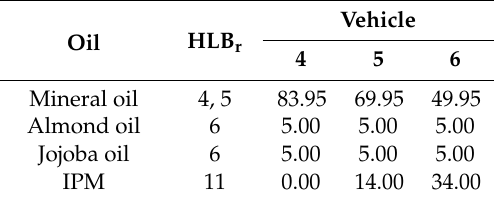
Table 3. Composition (% w / w ) of oil vehicles 4–6 and required hydrophilic lipohilic balance (HLB r